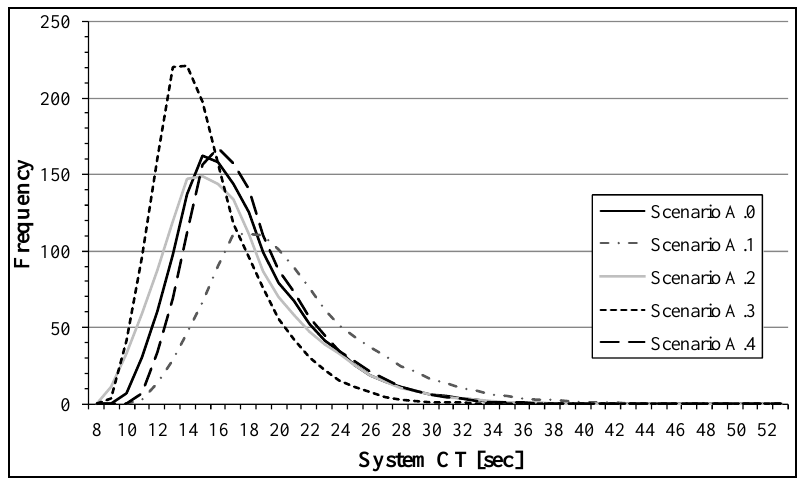
Figure 4. System cycle times output for Scenarios